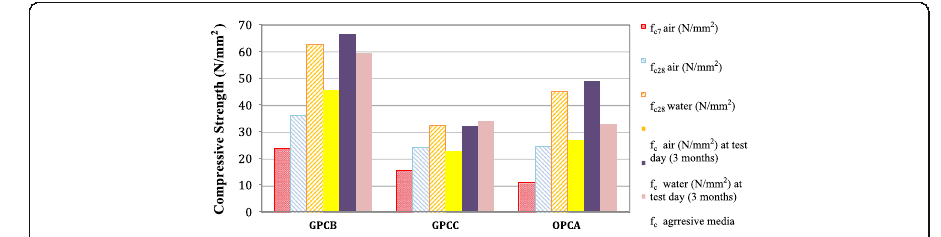
Fig. 10 The variation in compressive strength at different concrete mixes